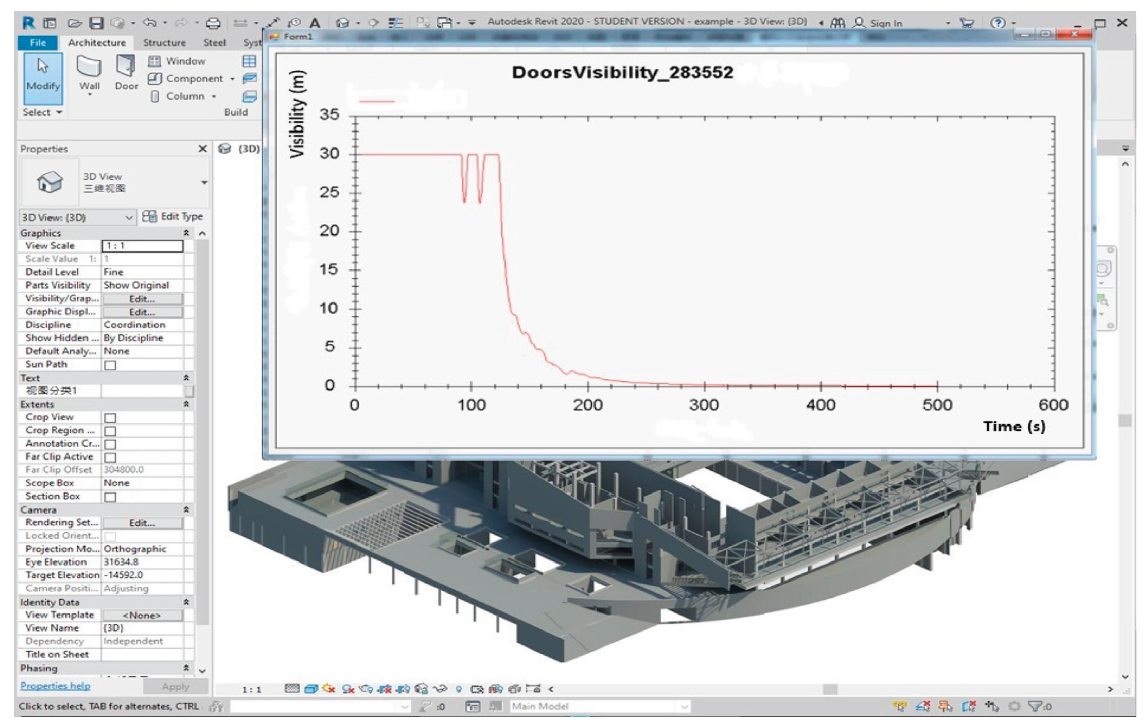
Figure 21: Data and diagrams of visibility near a